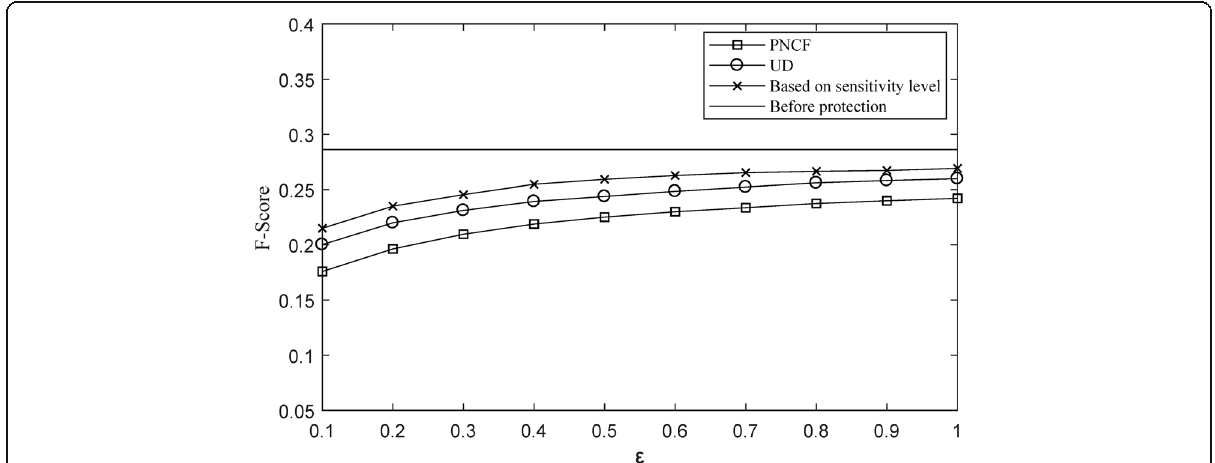
Fig. 8 F-Score of three different